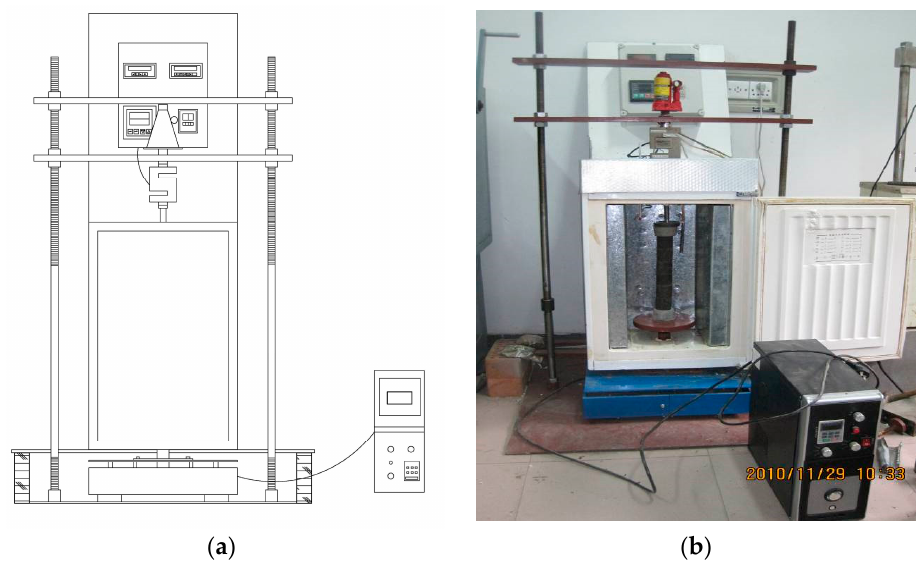
Figure 2. The setup developed for the fatigue testing of the CA mortar. ( a ) diagrammatic sketch of the setup and ( b ) the samples laid in the